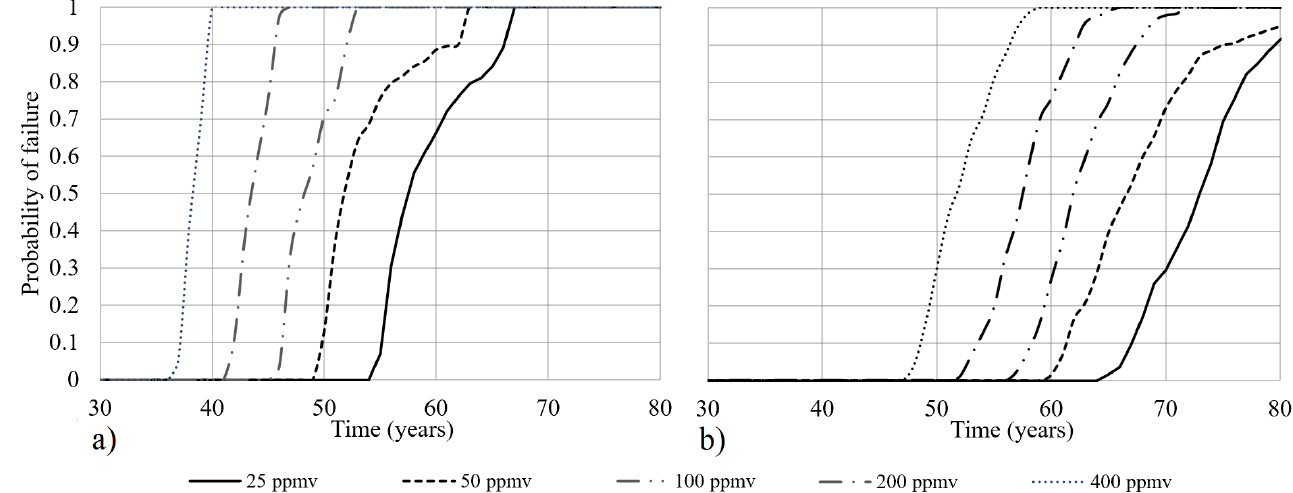
Figure 6. Probability of failure: ( a ) at the crown, and ( b ) at the waterline walls.